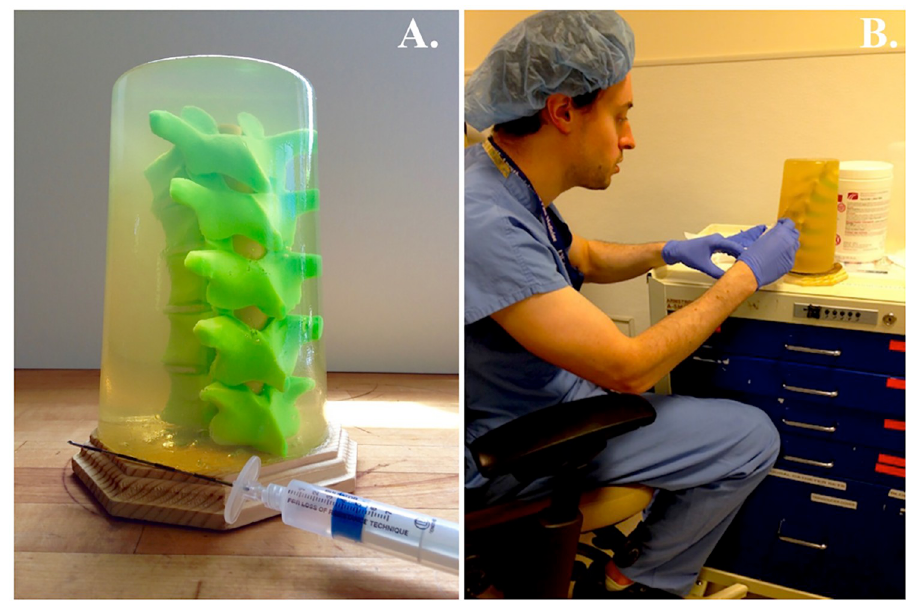
Fig 2. 3D-printed model. Thoracic epidural model (A) and trainee practicing thoracic epidural placement